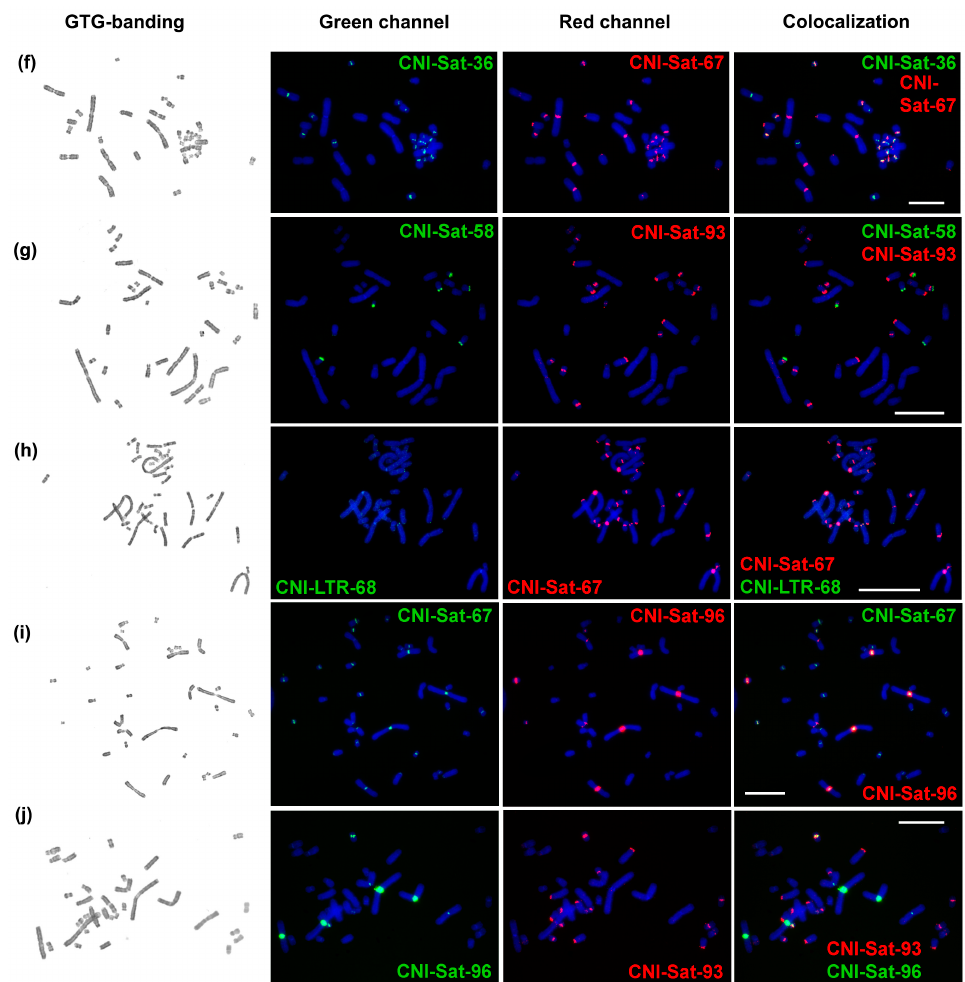
Figure 3. FISH of repetitive DNA probes on metaphase plates of Crocodylus niloticus . For each pair of probes from left to right, GTG-banded metaphase, green channel, red channel, and the colocalization of probes are shown: ( a ) CNI-Sat-4 (green) and CNI-Sat-36 (red); ( b ) CNI-Sat-4 (green) and CNI-Sat-67 (red); ( c ) CNI-Sat-19 (red) and CNI-Sat-67 (green); ( d ) CNI-Sat-19 (red) and CNI-Sat-96 (green); ( e ) CNI-Sat-39 (green) and CNI-LTR-48 (red); ( f ) CNI-Sat-36 (green) and CNI-Sat-67 (red); ( g ) CNI-Sat-58 (green) and CNI-Sat-93 (red); ( h ) CNI-Sat-67 (red) and CNI-LTR-68 (green); ( i ) CNI-Sat-67 (green) and CNI-Sat-96 (red); ( j ) CNI-Sat-93 (red) and CNI-Sat-96 (green). Scale bar 10 µm.